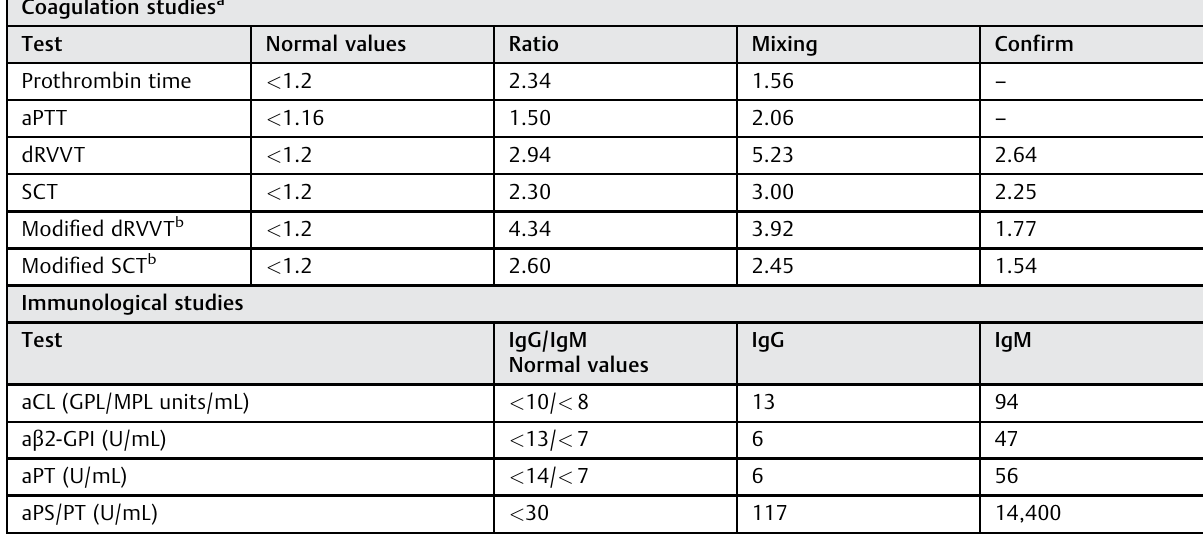
Table 1 Patient ’ s coagulation and immunological studies at hospital admission Coagulation studies a